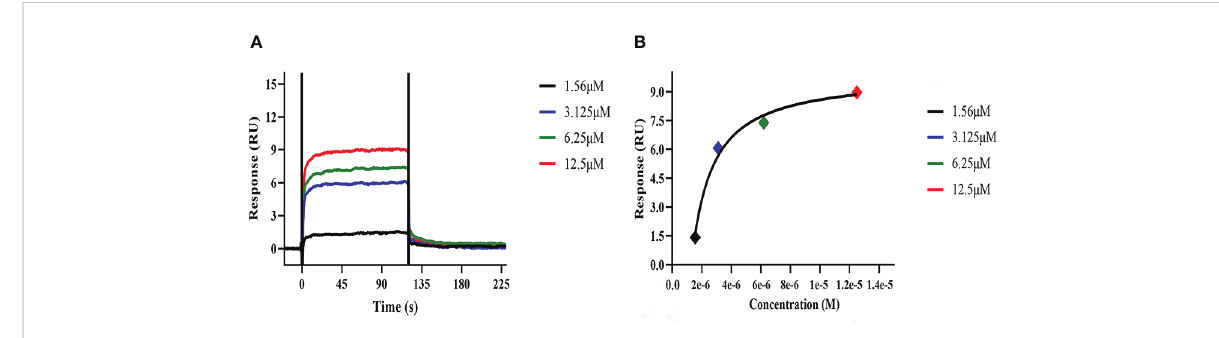
FIGURE 5 The af fi nity and kinetic analysis of ACE2 ― sitagliptin. (A) Response value of interaction between sitagliptin and ACE2 on CM5 chip; (B) Af fi nity fi tting curves corresponding to reporting points of gradient